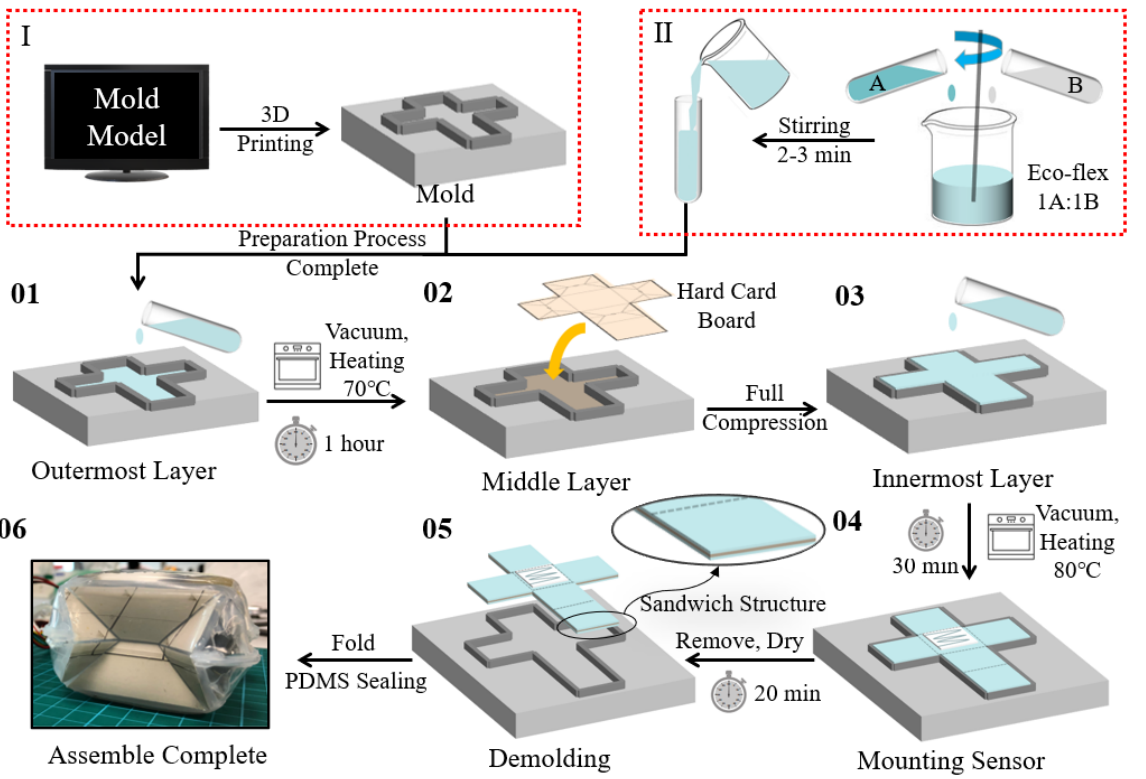
Figure 4. The fabrication process of the pressure-aware foldable structure can be mainly divided into the preparation process and layered the curing process. The preparation process includes I. The molding fabrication is by 3D printing and II. The Eco-Flex mixing solution preparation. After the preparation, the layered curing processes follow the steps: 01. Molding the outermost layer molding. 02. Attaching the middle layer. 03. Molding the innermost layer. 04. Mounting the proposed microfiber sensor. 05. De-molding the model of the sandwich structure. 06. Folding and PDMS, sealing the structure. To accelerate curing and compactness between layers, the molding procedure is processed in the vacuum oven with a temperature of 70 ◦ C to realize accelerated curing and bubble